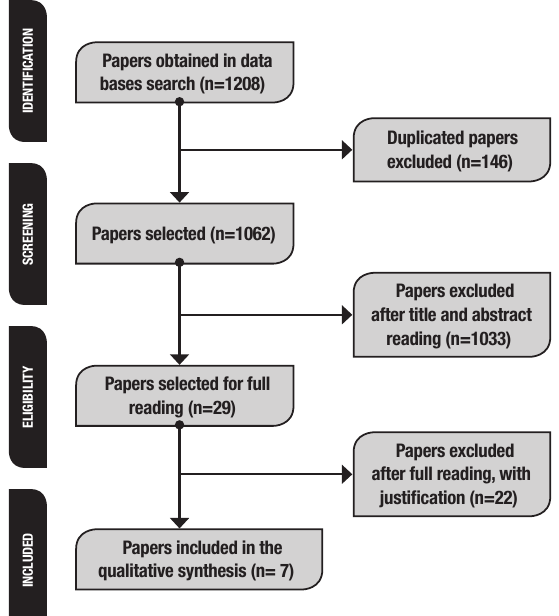
Figure 1. Illustrative Summary of Paper Selection process for the Systematic Review (PRISMA) Method, São Carlos, SP, Brazil,